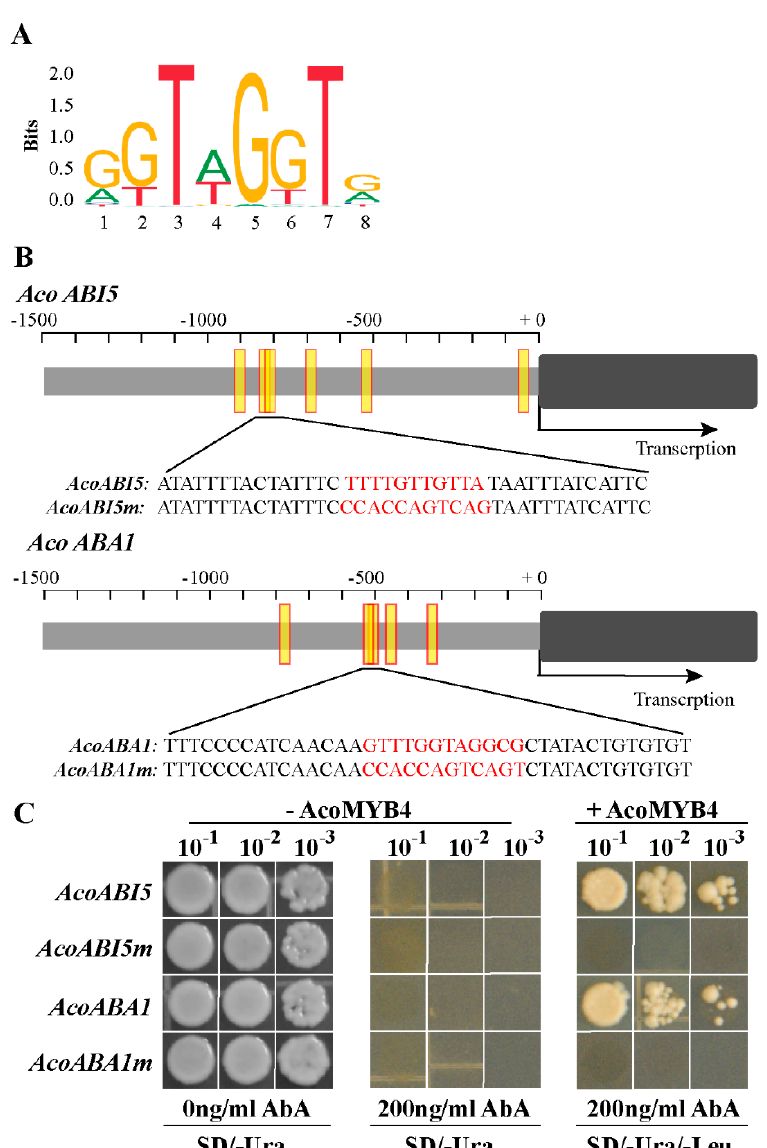
Figure 8. AcoMYB4 binds to the promoter of AcoABI5 and AcoABA1 . ( A ) The binding sequence logo of MYB4 downloaded from JASPAR. ( B ) The binding site of MYB4 was predicted to be in the cis-elements of AcoABI5 and AcoABA1 and the magnified region shows the specific binding site and its mutation sequence ( AcoABI5m and AcoABA1m ). The yellow box indicates the location of the binding site. ( C ) Yeast one-hybrid assay using vectors contains MYB4 binding site or fragments with introduced mutations. Yeast cells carting or lacking pGAD-AcoMYB4 were grown on SD / -Ura or SD / -Ura, SD / -Ura / -Leu containing 200 ng / mL AbA.